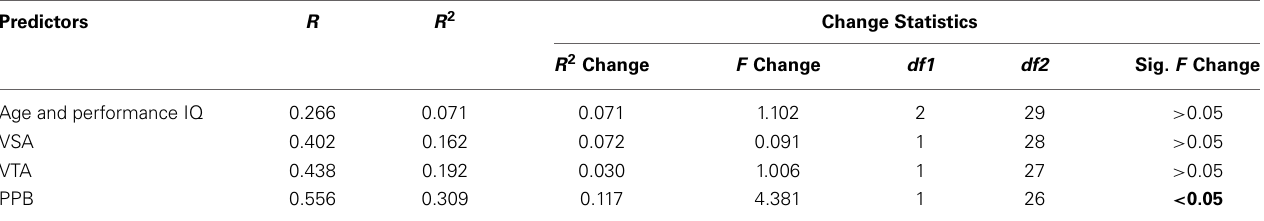
Table 8 | Multiple regression analysis with irregular word reading accuracy as the dependent variable and the following predictors entered at the four steps: (i) age and Performance IQ, (ii) time-course of visual spatial attention (VSA; RT difference between cuing effect at 350 and 100ms SOA), (iii) time-course of visual temporal attention (VTA; difference between signal accuracy and signal + noise accuracy), and